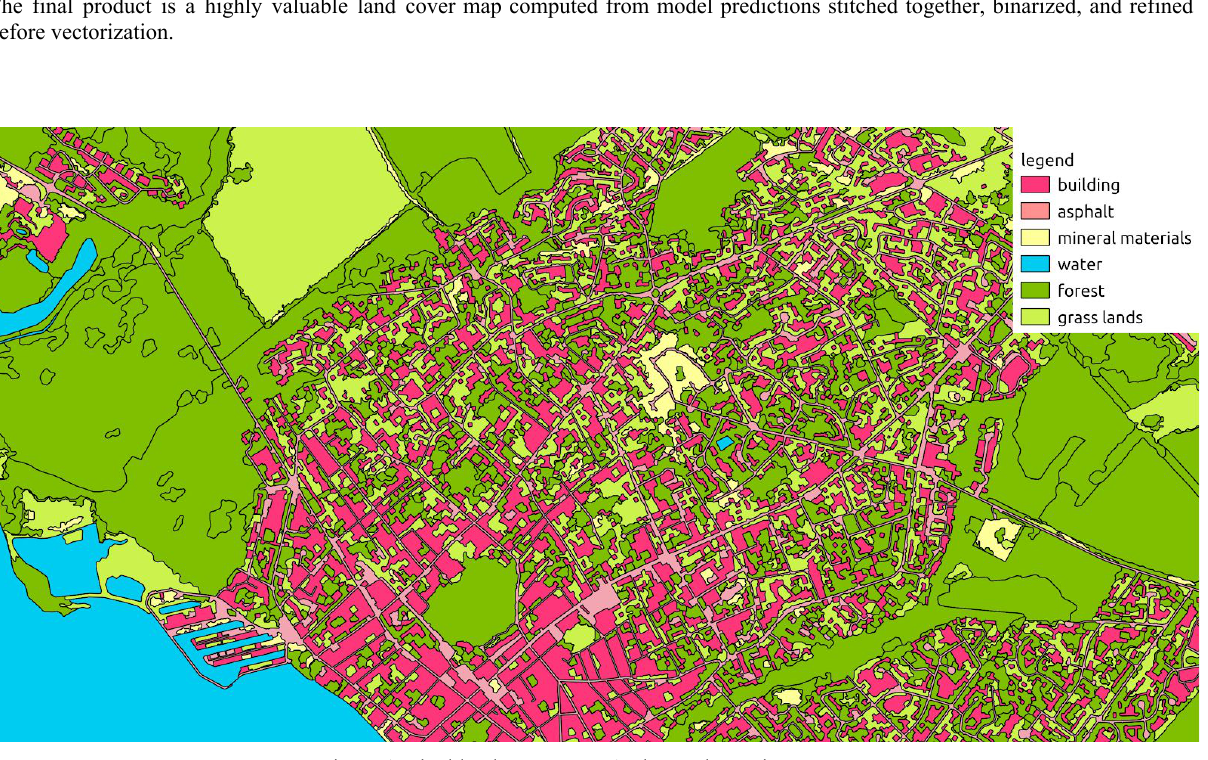
Figure 1. Final land cover map, Andernos-les-Bains,